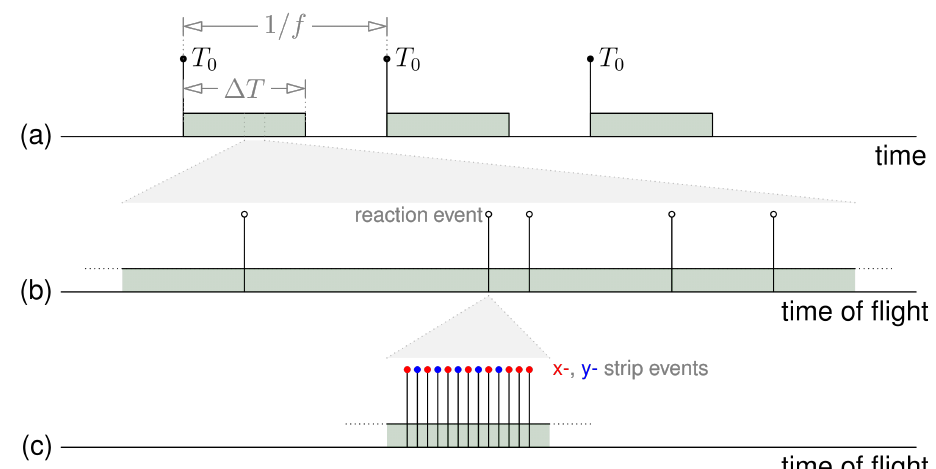
Figure 21. Time structure of the events. Each subsequent panel depicts an expanded view of a part of the previous one. In the upper panel ( a ), the pulsed neutron source provides neutrons during a limited time window ∆ T . The neutron production pulses are repeated with a frequency f and indicated by a trigger T 0 providing the start for the time of flight of reaction events in a single pulse, which are visualized in panel ( b ). Each reaction event will trigger an ionization track detected by a cluster of several adjacent x- and y-strips as shown in panel ( c ). The coarse structure in panel ( b ) provides the incident neutron energy by its time of flight, while the fine structure of the timing of the strip events in panel ( c ), combined with the amplitude information, provides information on the particle track.